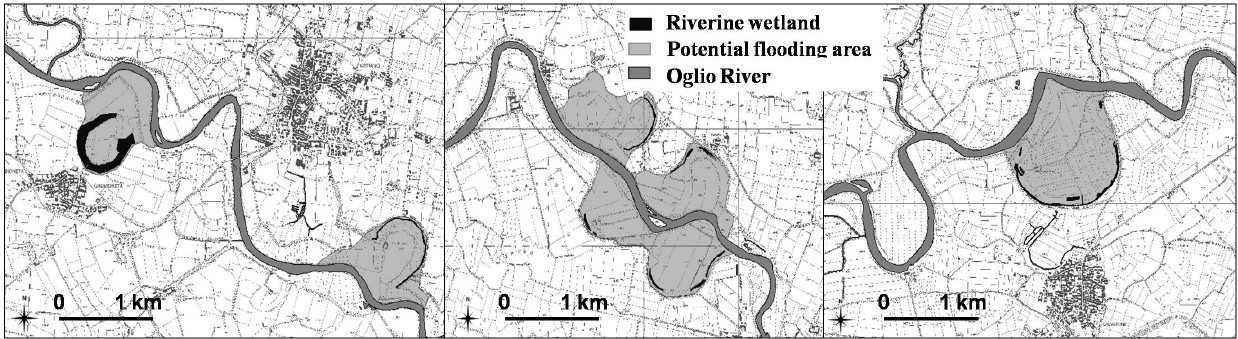
Fig. 5. Examples of relict wetland habitats within the Oglio River watershed. These oxbow lakes have a surface varying between 0.60 and 8.28ha, which is small compared to the area that can be potentially flooded by the Oglio River (from 44.06 to 95.87ha).